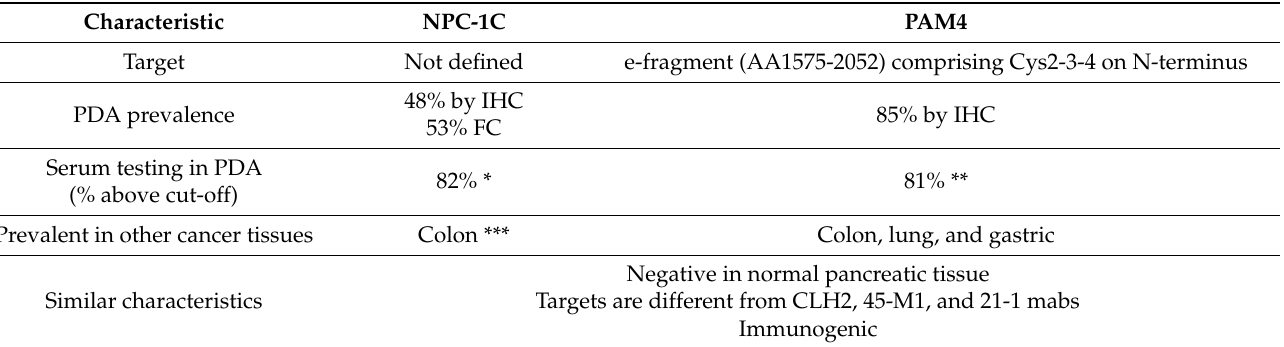
Table 3. NPC-1C and PAM4 monoclonal antibody in pancreatic ductal adenocarcinoma.